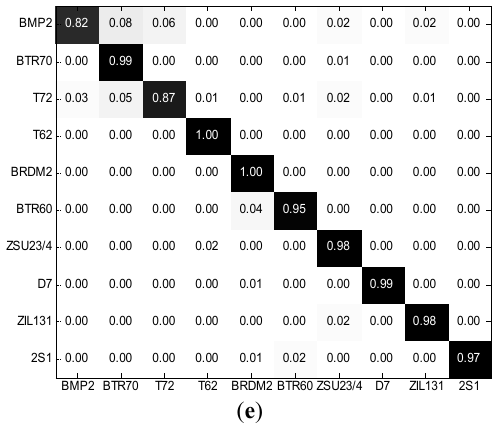
Figure 7. Confusion matrices of the reference methods: ( a ) SVM; ( b ) CNN; ( c ) Segment–SRC; ( d ) Original–SRC; and ( e ) Target–SRC. Table 3. Recognition results of the proposed method under SOC. (PCC: probability of correct classification). Class